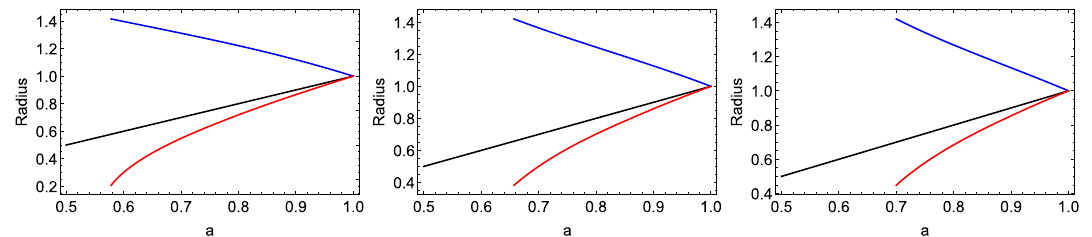
= 3. The red, black and blue curved are event horizon, thermalon γ Fig. 4 Location of horizons as a function of a ∗ when k = 1, L = 1, c λ = 0 . 2, left: γ = − 2 . 393 ,γ = 2 . 197 ,γ = 0, middle: γ = (bubble) location and cosmological horizon respectively a b c a − 0 . 931, γ = − 0 . 035, γ = 1 . 5, right: γ = 0 . 532, γ = − 2 . 266, b c a b